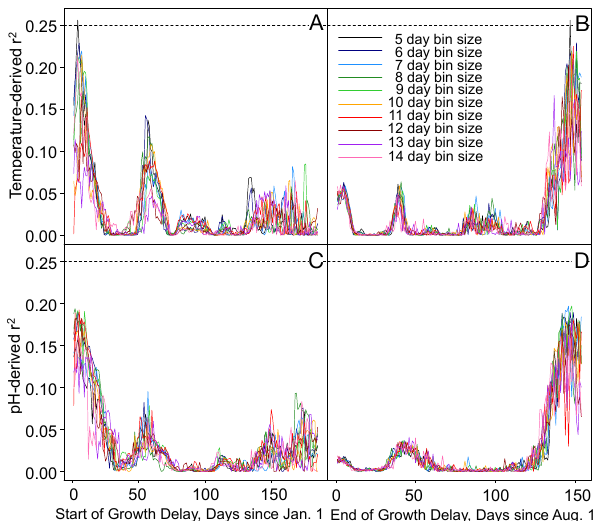
Fig. 2. Coefficients of variation ( r 2 ) for sinusoidal growth models. Panels shows r 2 between B concentration (ppm) and water temper- ature ( A , B ) and pH ( C , D ) based on growing season lag times for onset of the growing season ( A , C ) and termination of the growing season ( B , D ). Each color represents a different bin size for envi- ronmental data: 5 days, black; 6 days, navy blue; 7 days, blue; 8 days, dark green; 9 days, light green; 10 days, orange; 11 days, red; 12 days, dark red; 13 days, purple; 14 days,